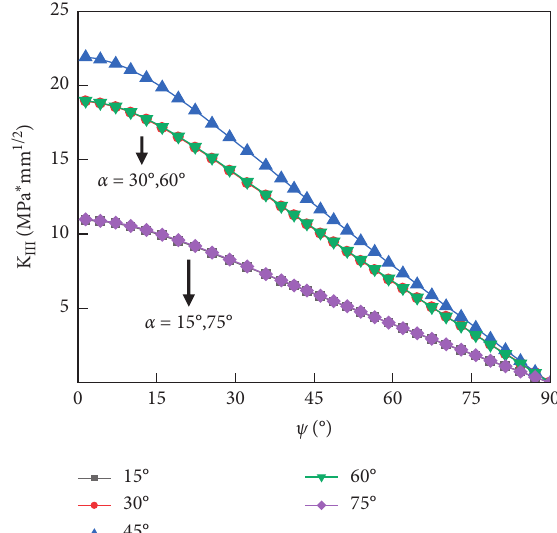
Figure 12: Numerical simulation results of K